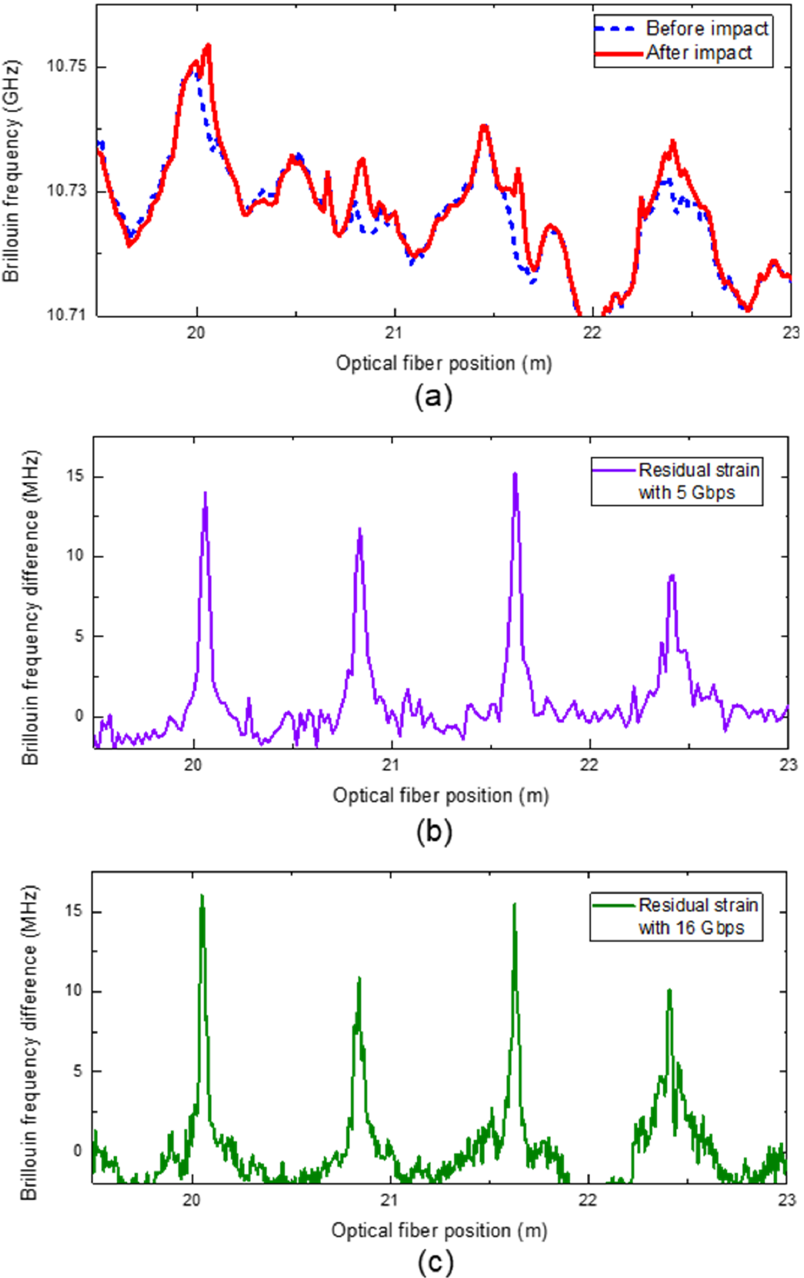
Figure 5. The frequencies before and after impact as solid and dashed lines ( a ), and the difference between both frequencies using 5 Gbps measurement ( b ), and 16 Gbps measurement ( c